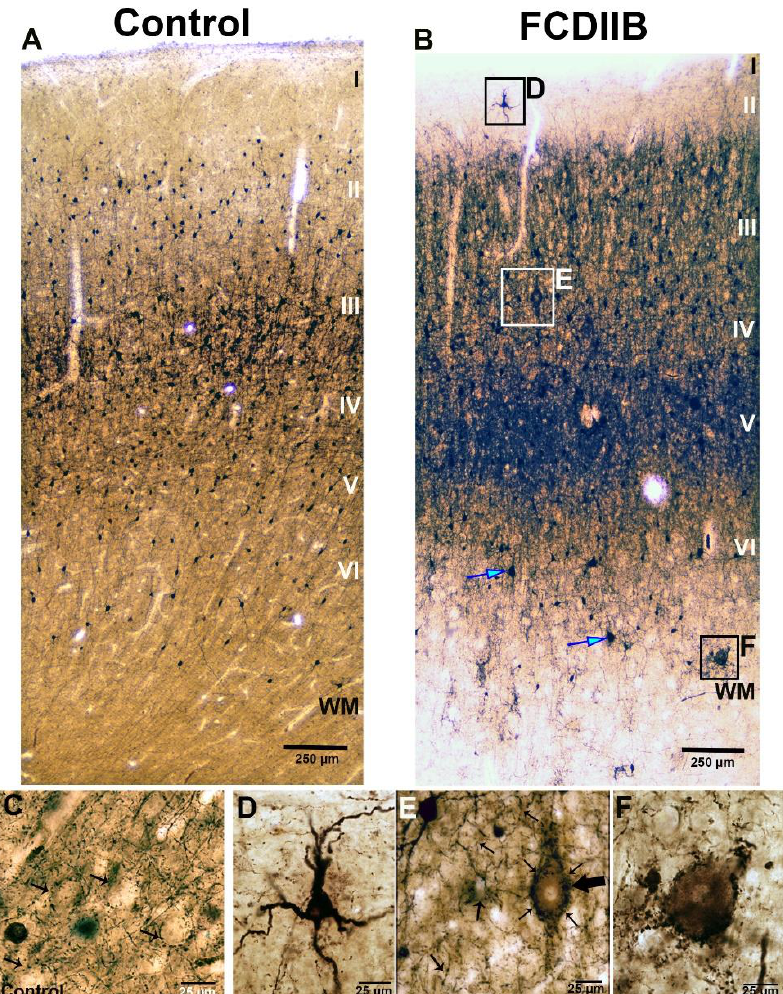
Figure 3. Parvalbumin (PV)-immunopositive elements in a control sample ( A , C ) and in an epileptic patient with FCDIIB in the frontal cortex ( B , D – F ). PV is present in a subgroup of perisomatic inhibitory cells. The maximum fiber density is found from layer III to layer V, both in the control and in the epileptic subjects (( A , B ): the layers marked by roman numbers). Numerous interneurons are present in both subjects, they are heterogeneous and multipolar, and smaller in number in the epileptic cortex ( B ). Presumable dysmorphic interneurons are also present in the dysplastic cortex (( B ): blue arrows, ( D )). The fiber density is higher in the dysplastic cortex ( B ), the dysmorphic neurons (( E ), large arrow) are surrounded by extremely dense PV-immunopositive terminals (( E ), small arrows). The small arrows show the negative cells—presumably principal cells—surrounded by PV-immunopositive baskets in control and epileptic samples ( C , E ). Panel F shows the hypertrophic PV-immunopositive basket formation in the white matter around a presumable hypertrophic cell. Scales: ( A , B ): 250 µ m; ( C – F ): 25: µ